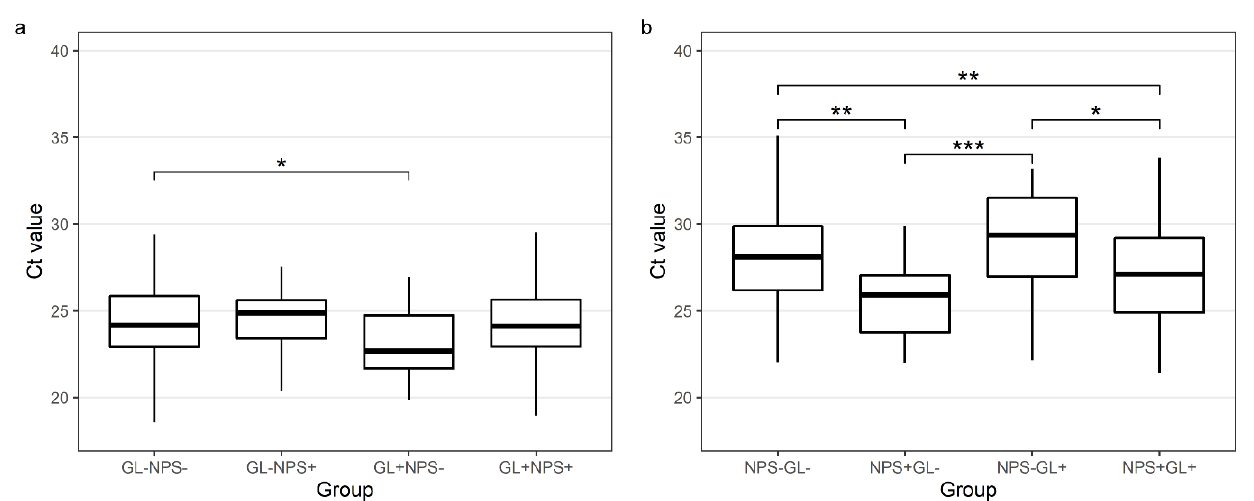
Figure 3. Comparison of Ct values for N , E , RdRP, and GAPDH genes in nasopharyngeal and gargle lavage samples with concordant and discordant results (GL+NPS − - — Ct values for gargle lavage samples for cases found positive only with gargle lavage samples; NPS+GL − -Ct values for nasopha- ryngeal swabs for cases found positive only with nasopharyngeal swabs; GL+NPS+-Ct values for E gene- E gene of SARS-CoV-2; N gene- N gene of SARS-CoV-2; RdRP -gene for RNA-dependent RNA polymerase gargle lavage samples for cases found positive with both gargle and nasopharyngeal swabs; of SARS-CoV-2; GAPDH -gene for human glyceraldehyde-3-phosphate dehydrogenase; GL-gargle lavage; NPS- NPS+GL+-Ct values for nasopharyngeal swabs for cases found positive with both gargle and naso- nasopharyngeal swab; NA-not applicable; NPS+GL+—-Ct values for nasopharyngeal swabs for cases found pharyngeal swabs; E gene- E gene of SARS-CoV-2; N gene- N gene of SARS-CoV-2; RdRP -gene for positive with both gargle and nasopharyngeal swabs; NPS+GL − -Ct values for nasopharyngeal swabs for cases positive only with nasopharyngeal swabs; GL+NPS—-Ct values for gargle lavage samples for cases found positive RNA-dependent RNA polymerase of SARS-CoV-2; GAPDH -gene for human glyceraldehyde-3- only with gargle lavage samples; GL+NPS+-Ct values for gargle lavage samples for cases found positive with phosphate dehydrogenase (internal control). Calculated by Wilcoxon two-sample test (GL+NPS+ both gargle and nasopharyngeal swabs. * p -value for comparison of NPS+GL+ vs. NPS+GL − and GL+NPS+ vs. GL+NPS-, NPS+GL+ vs. NPS+GL-) with Bonferroni correction (across genes). *** p < 0.001. vs. GL+NPS − Ct values of all tested genes. Calculated using the McNemar test. § p -value for comparison of NPS − GL+ vs. NPS+GL+ and GL − NPS+ vs. GL+NPS+ GAPDH Ct values. Calculated using the Tukey test.